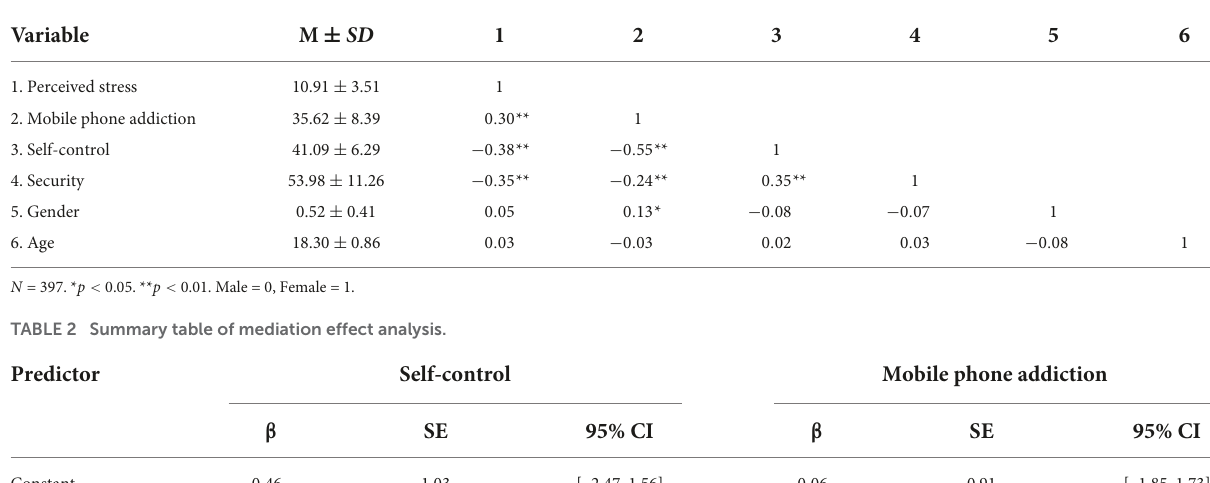
TABLE 1 Descriptive statistics and correlations among variables.